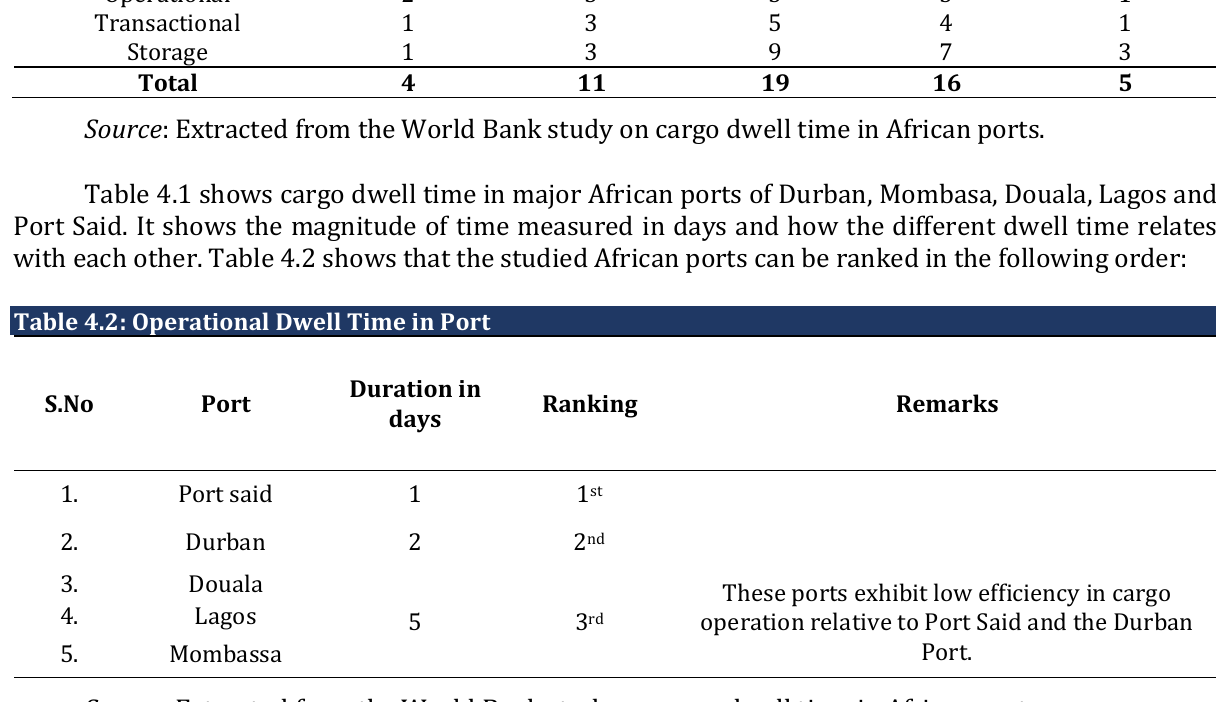
Table 4.3: Transactional Dwell Time in Port